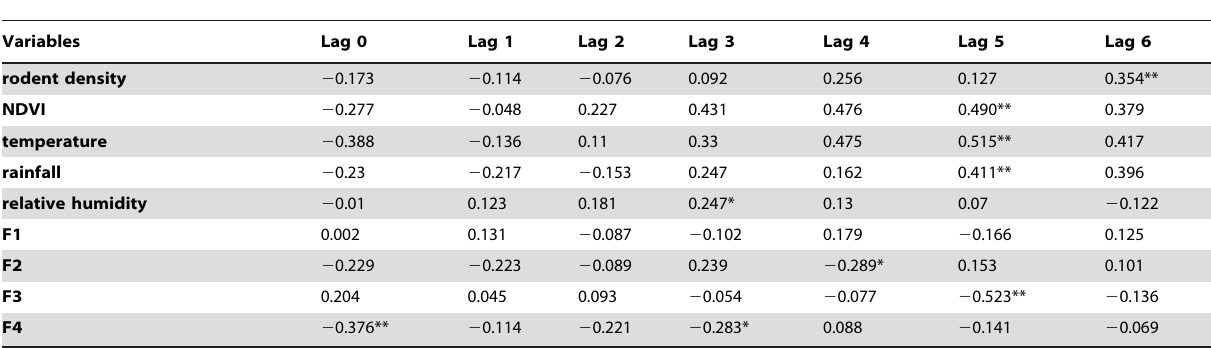
Table 4. Cross-correlation coefficients of the variables and notifications of HFRS.